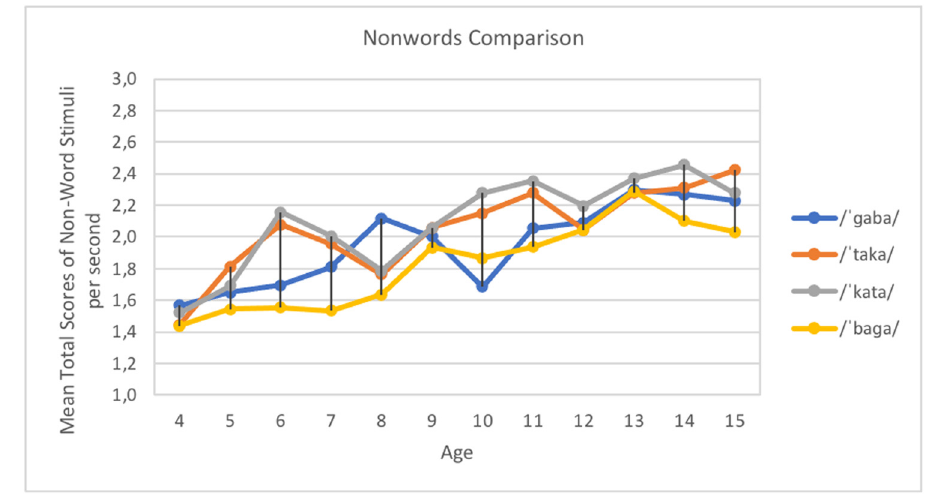
Figure 4: Non - word stimuli repetition per second by